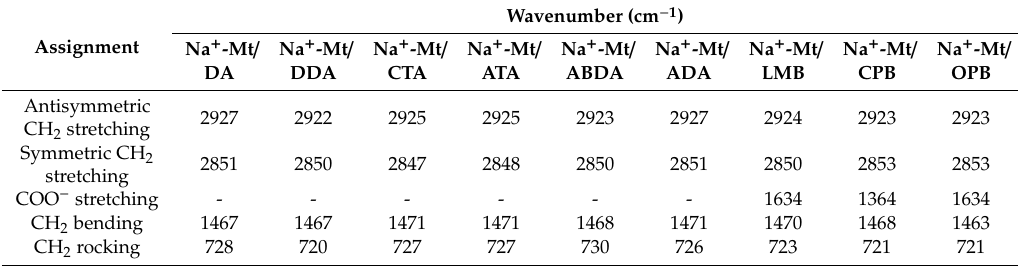
Table 2. Assignment of the main absorption bands in FTIR spectra of